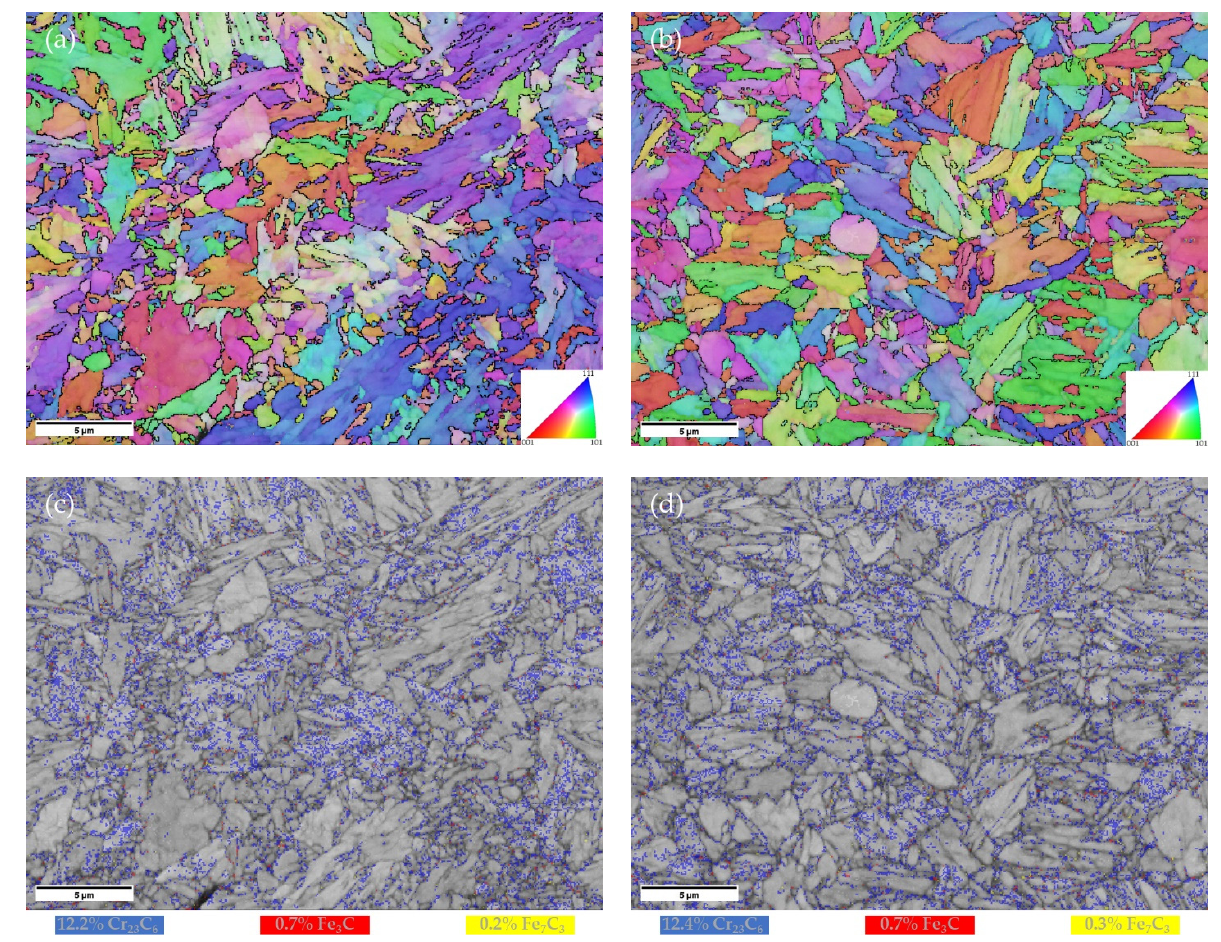
Figure 3. Inverse pole figures (IPF) of the tempered W-4130 steel from ( a ) as-built and ( b ) water- quenched conditions. Band contrast image overlapped by a map of indexed carbides for ( c ) AB & T and ( d ) Q & T steels of run #4.